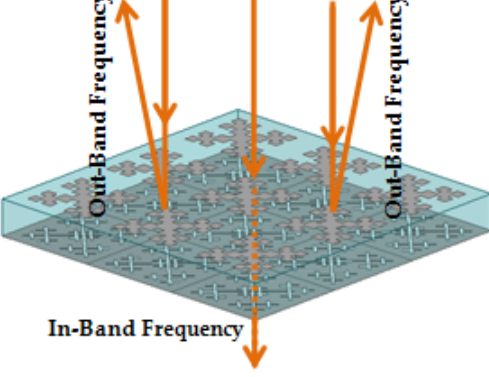
Figure 2. The functionality of an